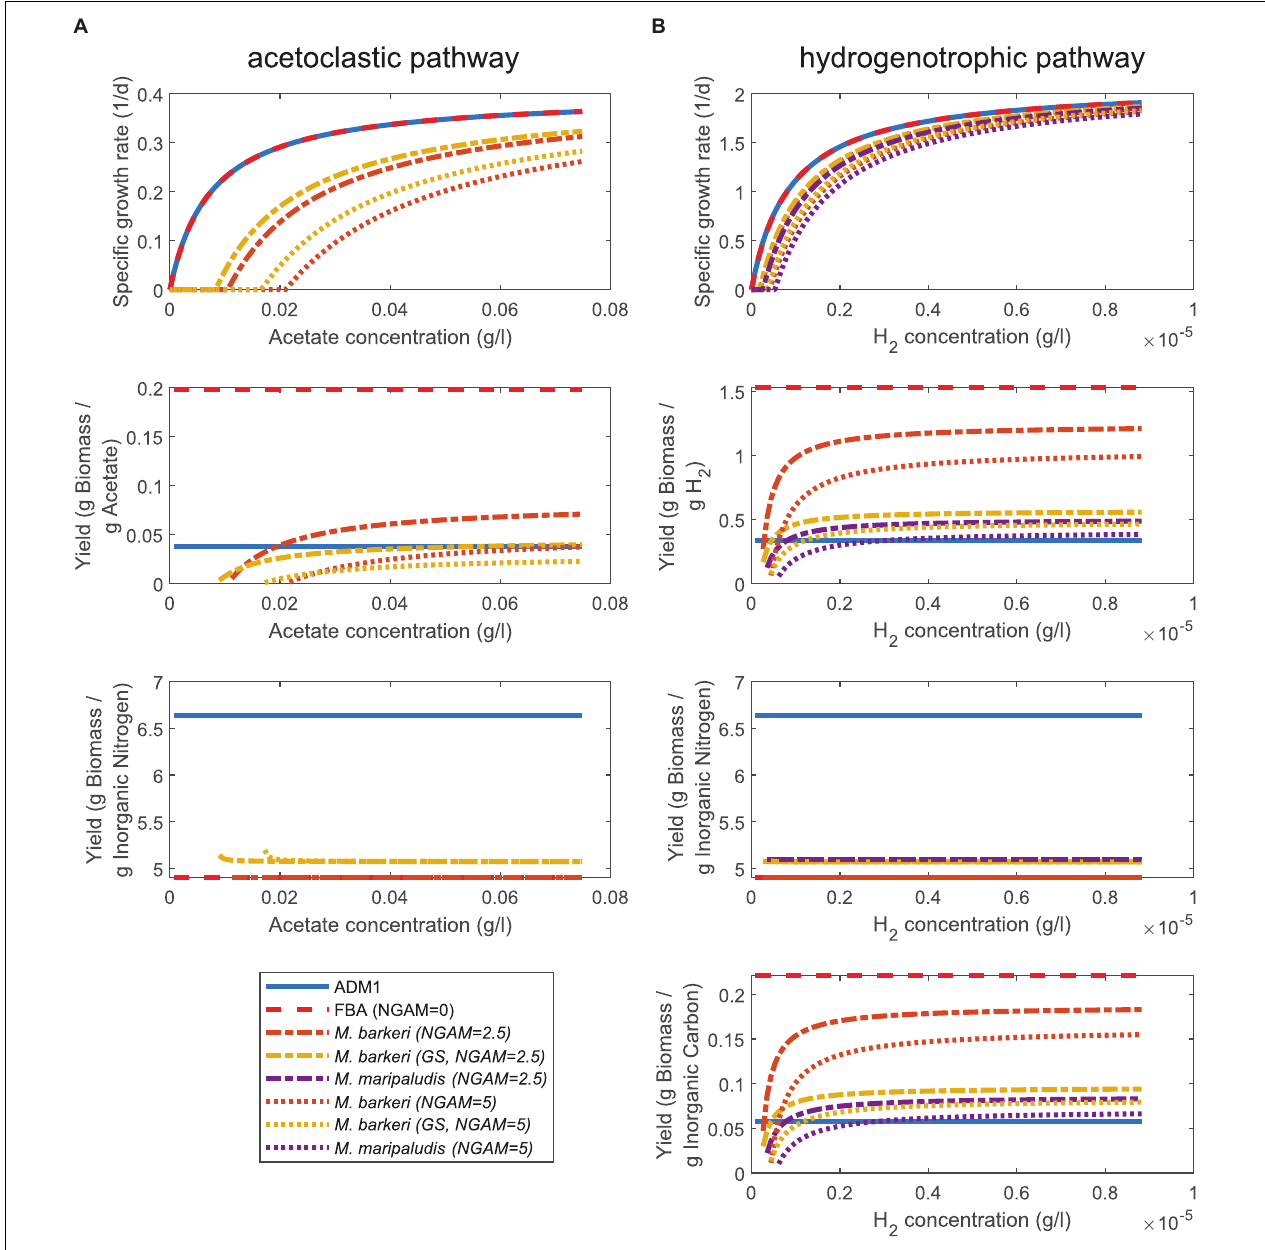
FIGURE 2 | Comparing growth and yield predictions under varying substrate concentrations for ADM1 and FBA models. (A) Acetoclastic methanogenesis pathway consuming acetate and inorganic nitrogen (NH 4 ). (B) Hydrogenotrophic methanogenesis pathway consuming hydrogen, inorganic nitrogen (NH 4 ) and inorganic carbon (CO 2 , HCO 3 −